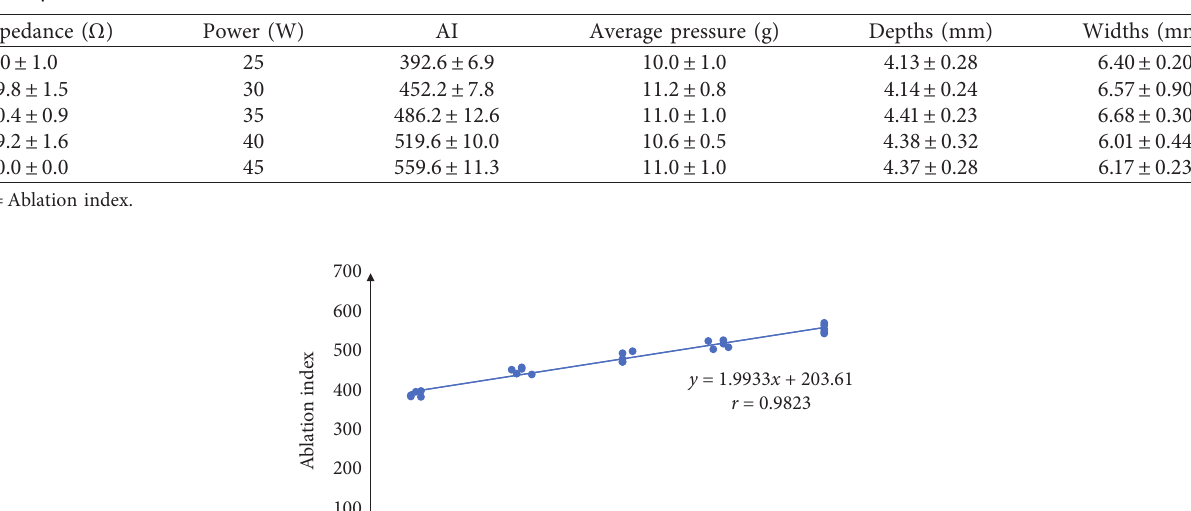
Figure 2: The lesion dimensions in increased baseline impedance and similar AI. Table 1: The relationship among different basic impedance, power, and the ranges of ablation damage when the current and pressure were relatively constant.